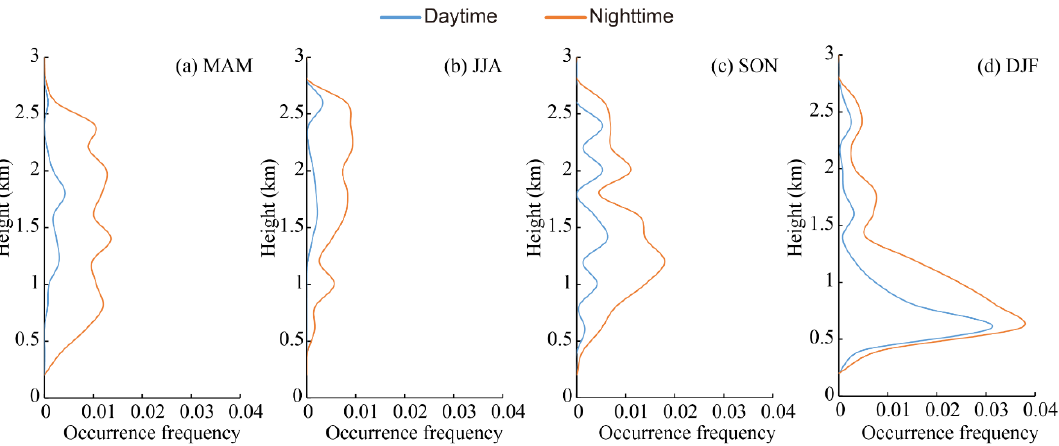
Figure 7. Vertical distribution of occurrence frequencies of polluted continental/smoke layer in the daytime and nighttime in the Aral Sea region from CALIPSO observations for four seasons.